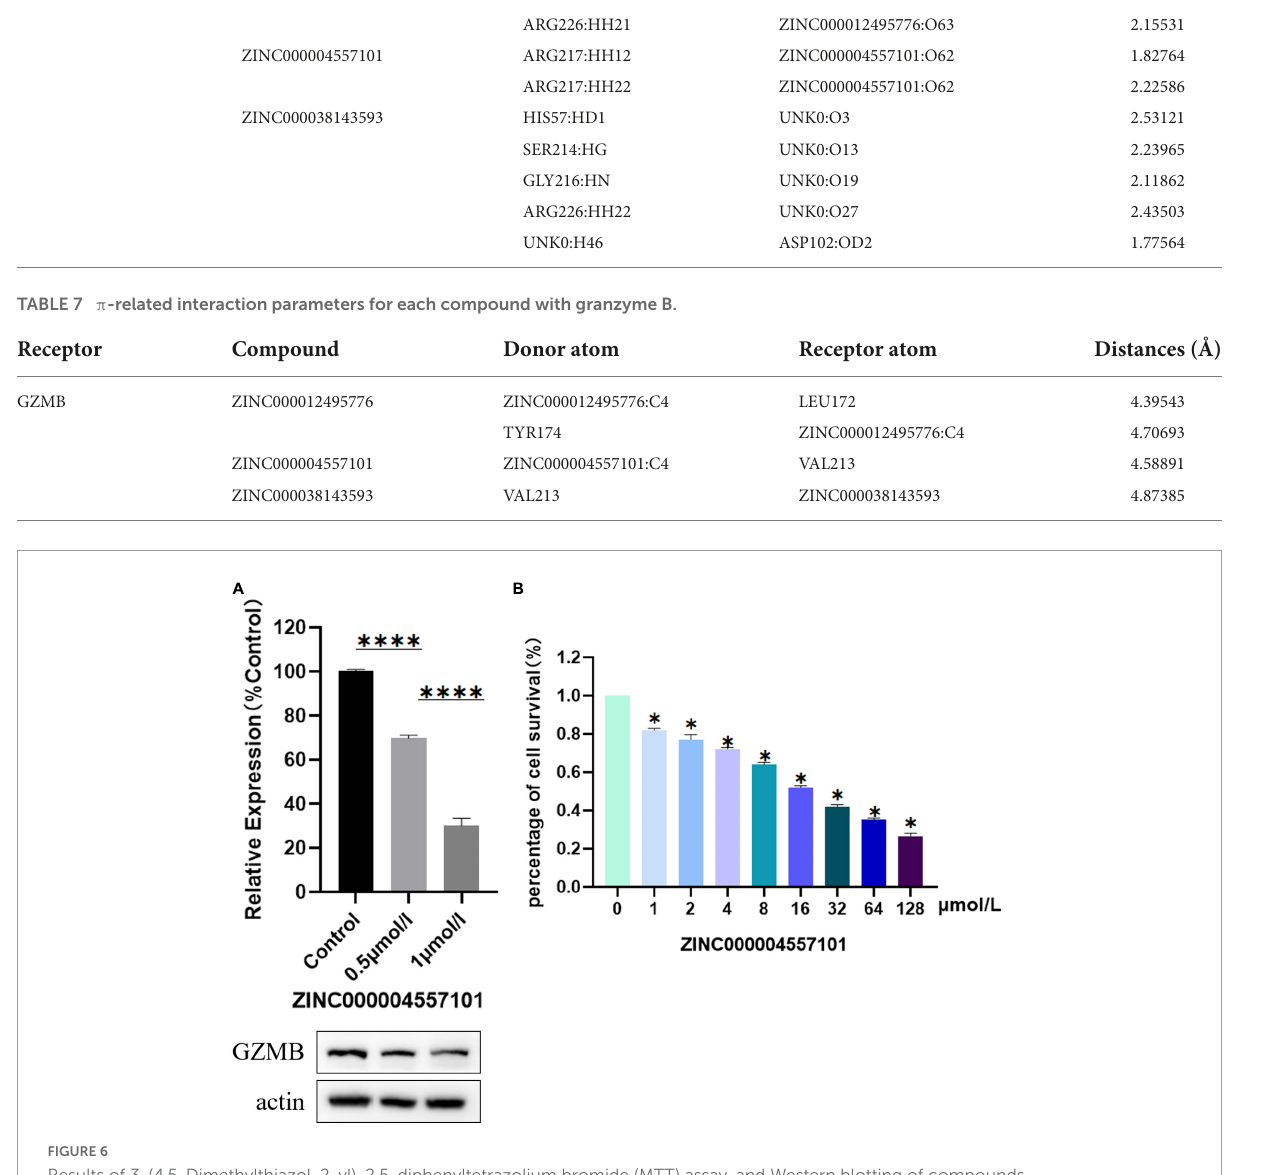
FIGURE6 Results of 3-(4,5-Dimethylthiazol-2-yl)-2,5-diphenyltetrazolium bromide (MTT) assay, and Western blotting of compounds ZINC000004557101. (A) Western blotting. (B) MTT assay.